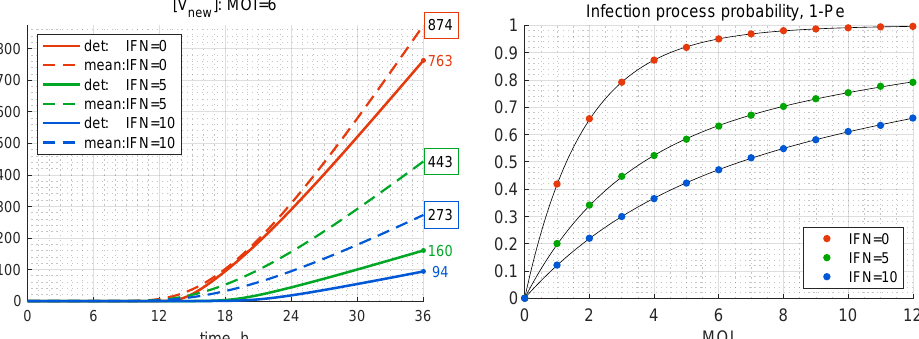
Figure 11. ( Left ) Time variation of the number of produced new virions according to the deterministic model (solid) and its mean value in the stochastic model (dashed) for MOI = 6 and different values of [ IFN e ]( 0 ) (the line colours are explained in the legend). The coloured numbers indicate the total number of new virions [V tot ] calculated by the deterministic model for different values of [IFN e ]. The black numbers in the coloured boxes indicate the mean values of [V tot ] computed by the stochastic model. ( Right ) Probability for productive infection of a target cell in relation to the initial number of free virions per cell MOI and the initial concentration of extracellular IFN (explained in the